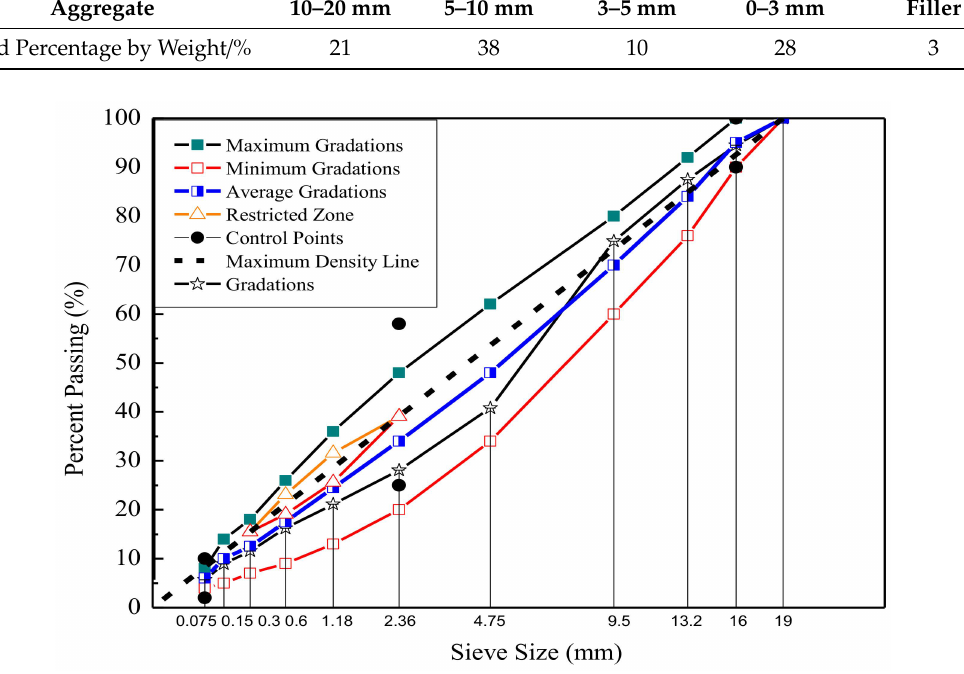
Figure 1. The gradation of crumb rubber-modified asphalt mixtures [24]. Table 2. Volumetric parameters of crumb rubber modified asphalt mixtures at optimum asphalt content